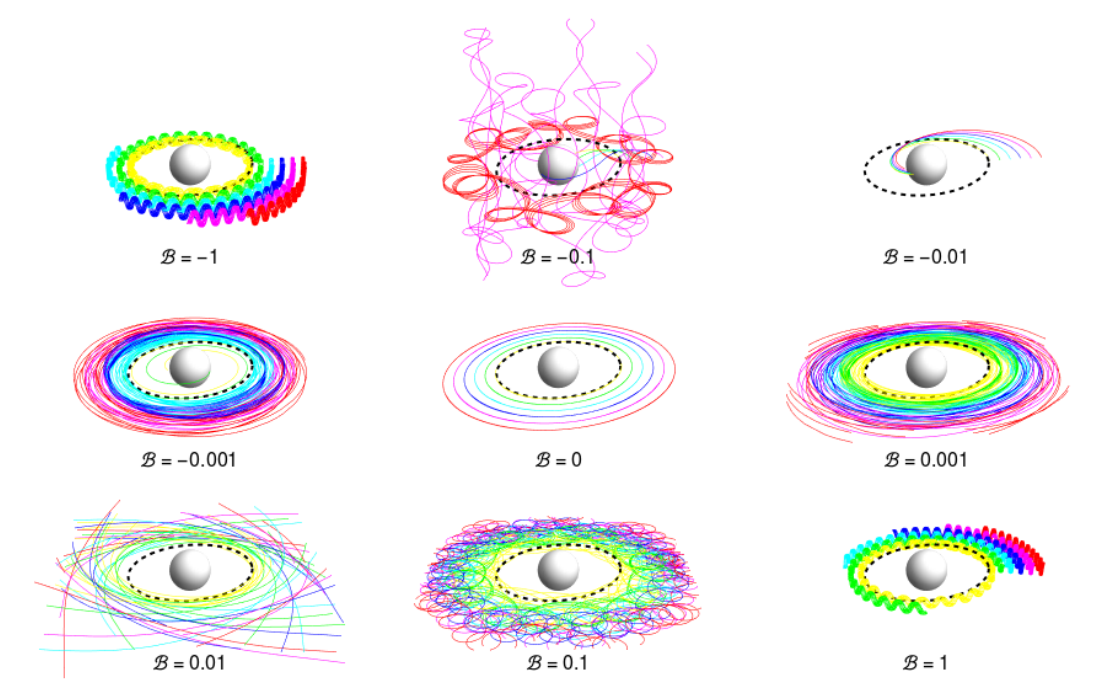
Figure 6. Thin Keplerian accretion disk around Schwarzschild BH in uniform magnetic field, created by neutral test particles following circular geodesics, and its evolution when the influence of the magnetic field is switched on. The accretion disk particles following initially circular orbits with slight inclination from equatorial plane ( θ 0 = 1.5), while the magnetic field lines are everywhere aligned with the z axis (vertical direction). The uncharged test particles on innermost stable spherical orbit (depicted by the dashed circle), represent the inner edge of the Keplerian accretion disk. If the disk will remain neutral or the magnetic field is missing ( B = 0 case, middle figure) all the orbits will remain in their circular shape and we see just inclined razor thin disk. If a slightly strong electromagnetic interaction is switched-on ( B = ± 0.001 cases, middle row), the charged particles forming the disk that is originally almost perpendicular to the magnetic field lines start to follow epicyclic oscillations around the circular orbit in both radial and latitudinal directions; the accretion disk becomes to be slightly thick. If larger magnetic field is switched-on ( B = ± 0.01, ± 0.1 cases), the charged particle motion becomes quite chaotic and the accretion disk is destroyed or transformed into thick toroidal structure. The complete destruction of the Keplerian disk can be seen in the B = − 0.01 case, when all the particles are captured by the black hole. If the magnetic parameter of the field that is switched-on is large ( |B| ≥ 1 cases), the Lorentz force dominates the particle motion. The charged particles are spiraling up and down along the magnetic field lines, while slowly moving around the black hole in the clockwise ( B > 0) or the counter-clockwise ( B < 0) direction. The thin Keplerian disk has been destroyed and transformed into some special thick toroidal